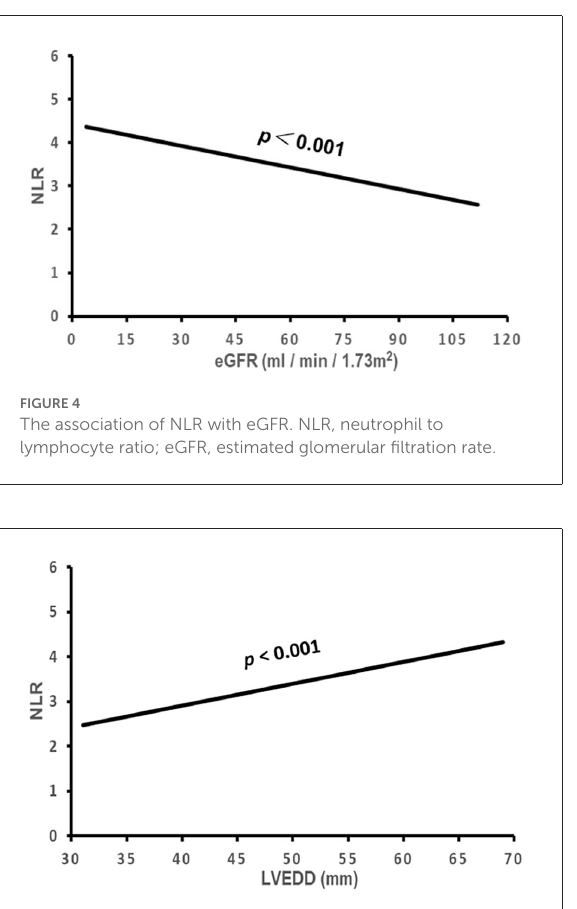
FIGURE5 The association of NLR with LVEDD. NLR, neutrophil to lymphocyte ratio; LVEDD, left ventricular end-diastolic diameter.